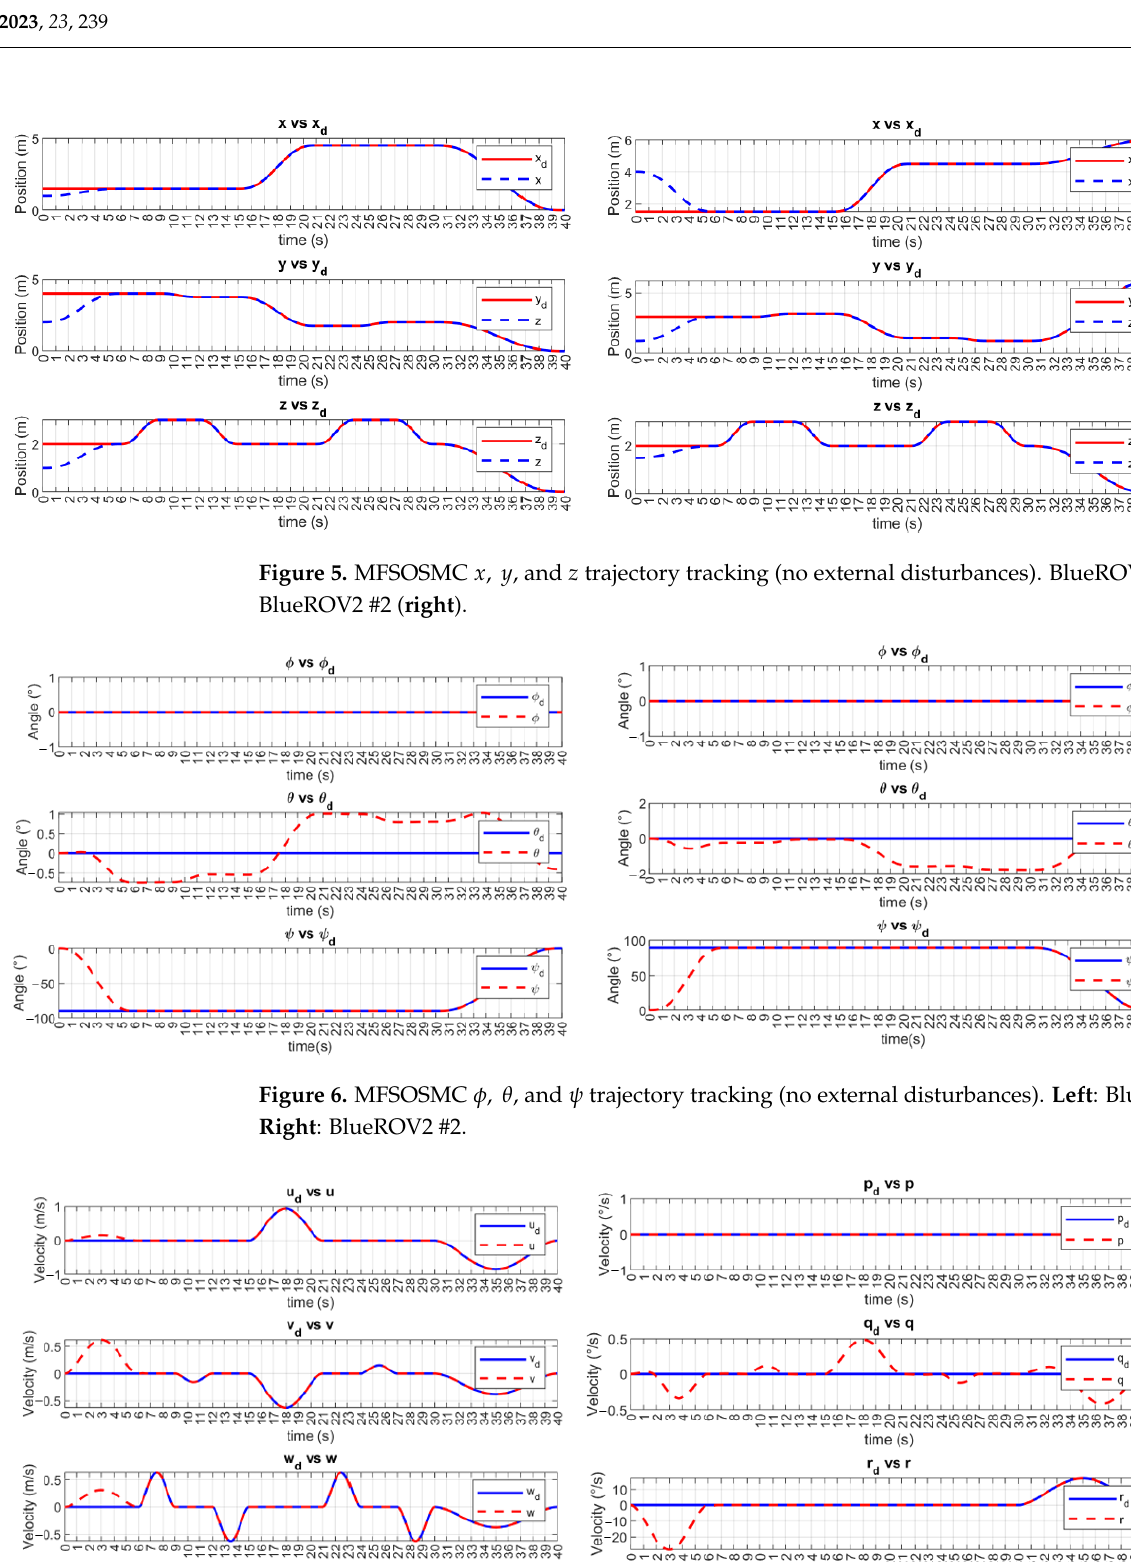
Figure 7. BlueROV2 #1 velocity tracking with the MFSOSMC (no external disturbances).